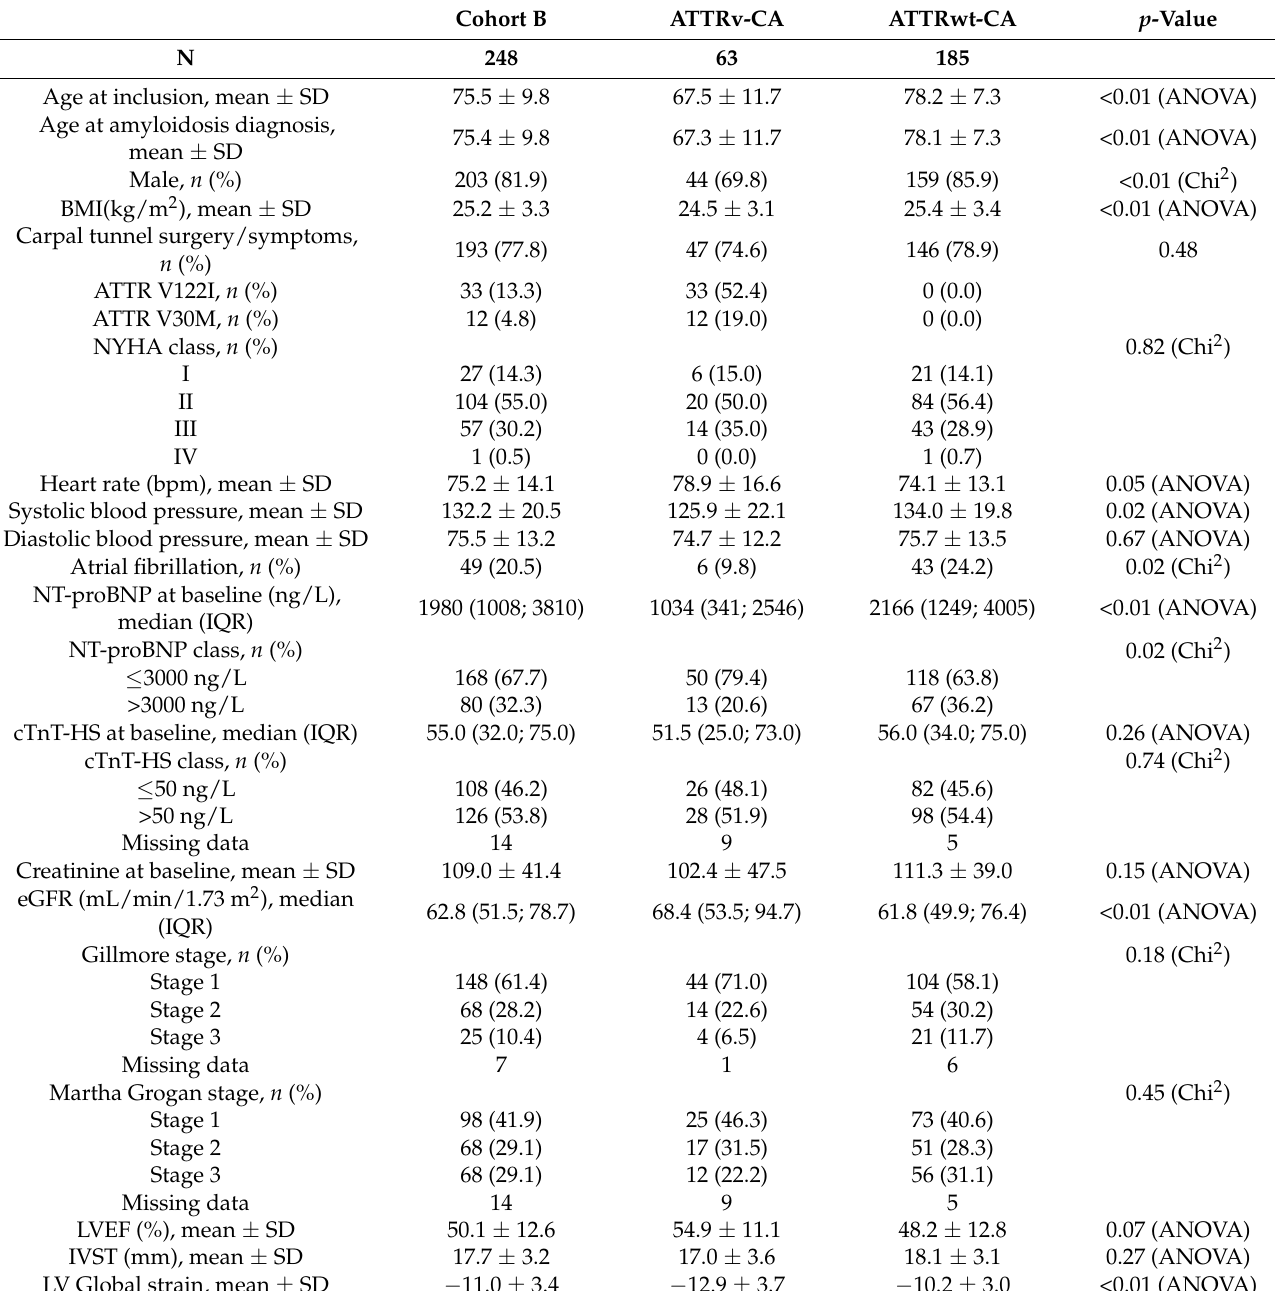
Table 2. Characteristics of patients treated with tafamidis (Cohort B) and with NT-proBNP assessments before and after initiating tafamidis ( n =